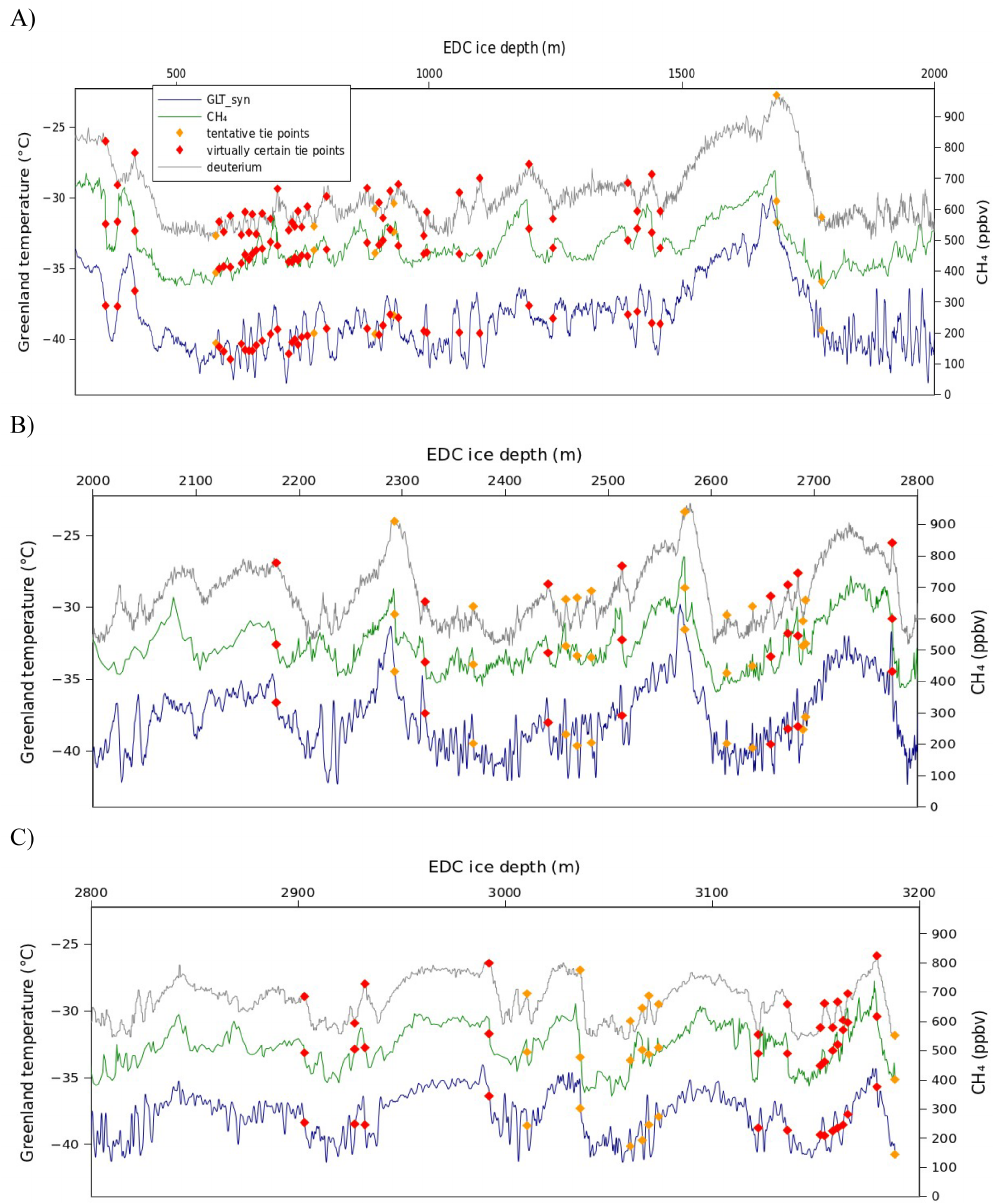
Fig. 7. Comparison between the GL T curve (Barker et al., 2011), the EDC CH 4 record (Loulergue et al., 2008) and the EDC δ D record syn (Jouzel et al., 2007): (A) in the depth interval 0–2000m, (B) in the depth interval 2000–2800m, (C) in the depth interval 2800–3200m. The deuterium record has been resampled on 100-yr